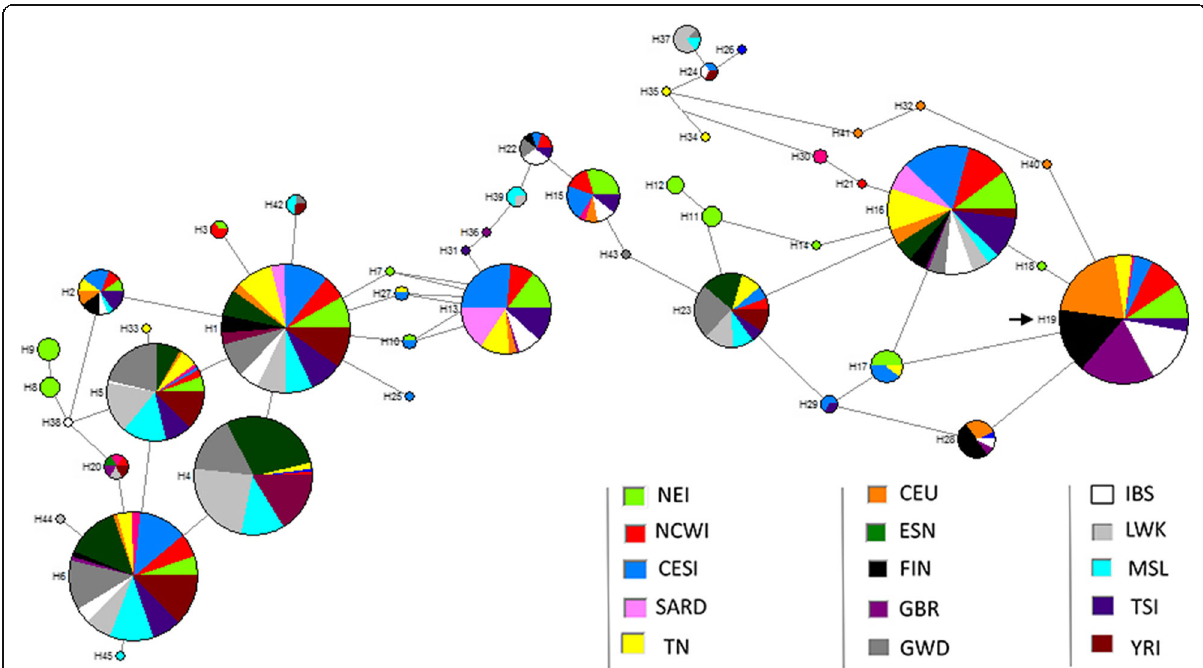
Fig. 3 Median joining network of the inferred haplotypes. Haplotypes proportions were displayed with different colors according to the different examined populations. Adaptive haplotype was indicated by